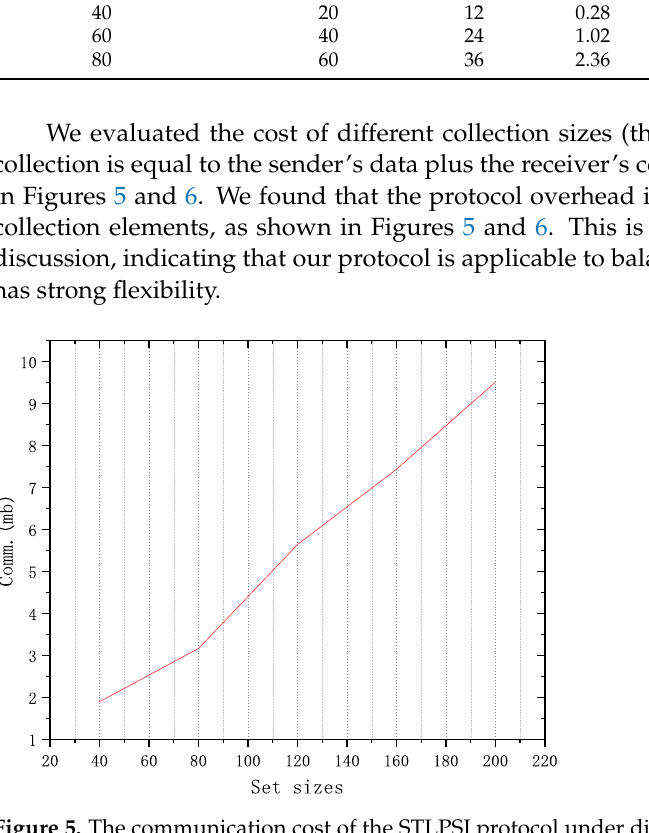
Figure 5. The communication cost of the STLPSI protocol under different set